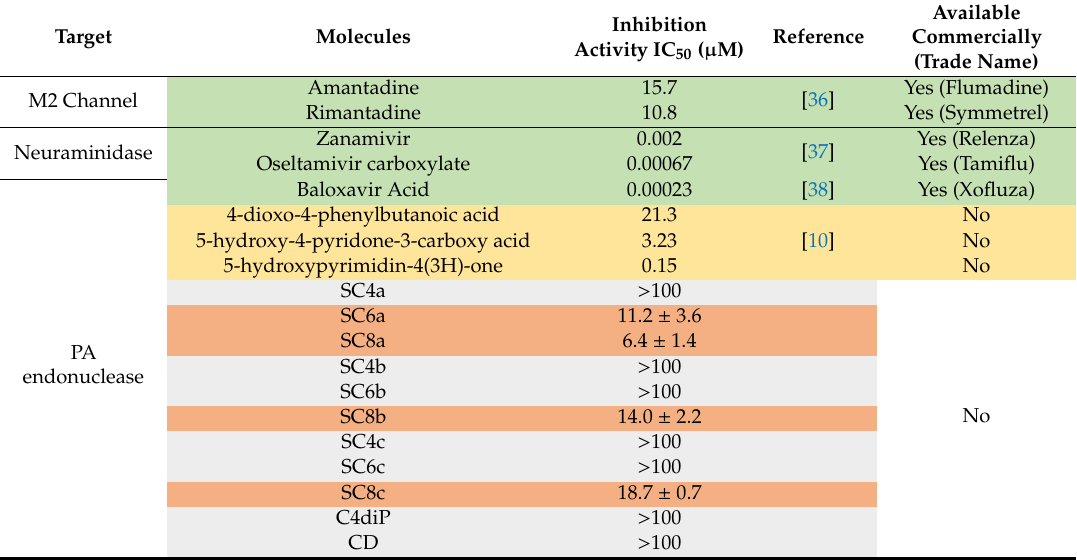
Figure 3. Scatter plot of digested DNA fraction as a function of calix[n]arene derivative concentration mixed with the couple DNA / endonuclease PA. IC 50 corresponds to the calix[n]arene derivative concentration that reduces 50% of the PA endonuclease activity. Errors bars correspond to the standard deviation of 3 different measurements. IC 50 of H3N2 endonuclease PA was determined for SCa at 6.4 μ M ( A ), SC8b at 14 μ M ( B ), SC6a at 11.2 μ M ( C ), and for SC8c at 18.7 μ M ( D ). Table 1. IC 50 values for inhibition of influenza virus pharmaceutical targets. Commercially available drugs that inhibit M2 channel, neuraminidase and PA endonuclease targets are in green. PA endonuclease inhibitors assessed only by in vitro assays are in yellow. Molecules investigated in this study are color coded in red to show inhibition below 20 μ M, and in grey for none inhibition observed under 100 μ M.